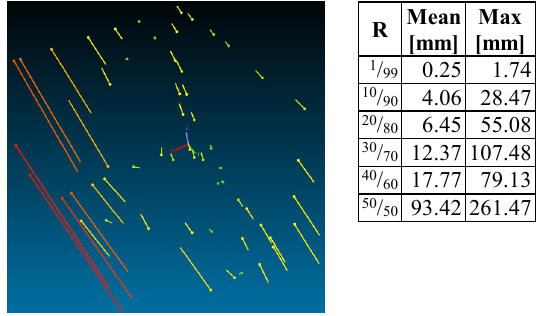
Figure 8. 3D error vectors (exaggerated by factor 100) of forward intersected 3D points of one exemplary image pair (dataset 2 MM -0°-10/90) using the calibrated parameters of interior and relative orientation. The mean and max values of the 3D errors are depicted in the table for each air/water ratio. The calibrated orientation parameters differ from the nominal values in a similar manner as the calibrated values of the convergent datasets shown in section 3.2.1. However, when analysing the error in object space, it becomes clear that the implicit form cannot model the system correctly. The larger the depth ratio of different media becomes, the more critical the errors in object space seem to be. Meaning that in close-range applications where the ratio becomes large (e.g. 1/1), modelling the refractive effects implicitly will lead to gross errors, whereas for applications with smaller ratios (e.g. 1/300) the modelling errors are smaller.